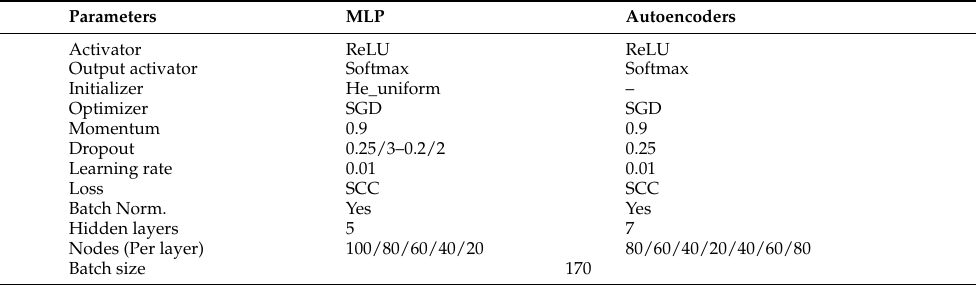
Table 5. Parameter values for the DNN algorithms. A value of “/3” or “/2” in the MLP Dropout parameter indicates the number of layers in which this parameter had the designated value. The layer values are calculated without including the input and output ones. A hyphen defines an irrelevant option for this DNN model. SCC stands for the Sparse Categorical Crossentropy.